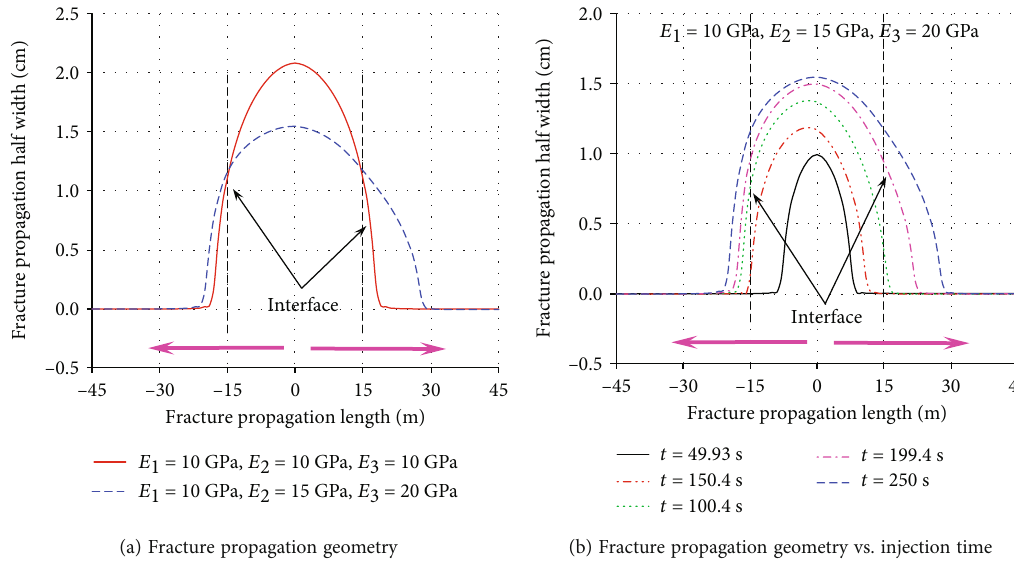
(b) Fracture propagation geometry vs. injection time Figure 10: The hydraulic fracture propagation characteristic in soft-medium-sti ff